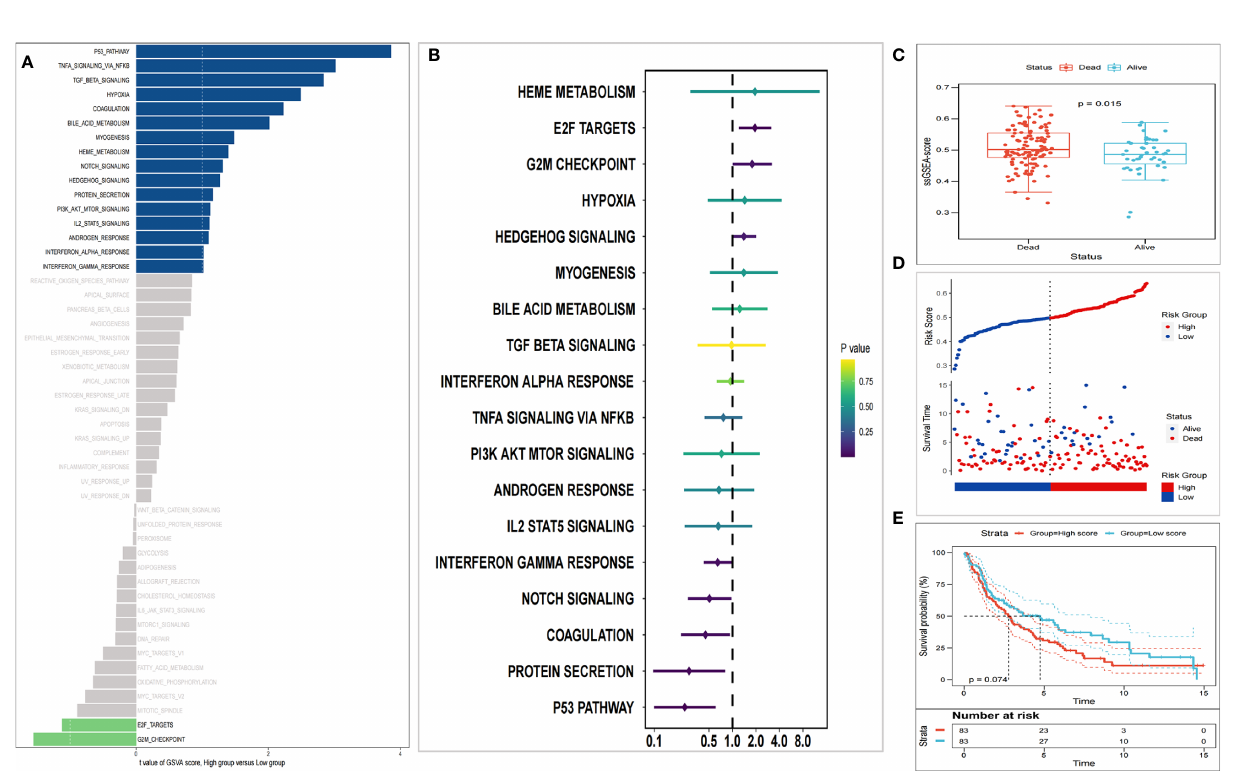
FIGURE 2 | E2F target is identi fi ed as the main risk factor of survival after radiation. (A) GSVA analysis showed signi fi cant changes in 18 cancer-related pathways ( t > 1). (B) Univariate Cox regression analysis exhibits that E2F targets were the main risk factors among diverse cancer biomarkers. (C) The E2F ssGSEA score of patients who died during the follow-up period increased signi fi cantly. (D) Kaplan-Meier analysis suggested poorer OS of patients with higher E2F ssGSEA scores. (E) Patients with higher E2F scores have shorter